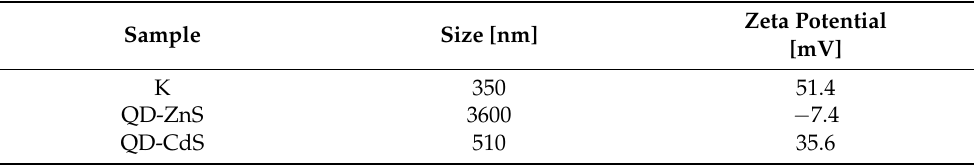
Table 5. Analysis of the sizes and zeta